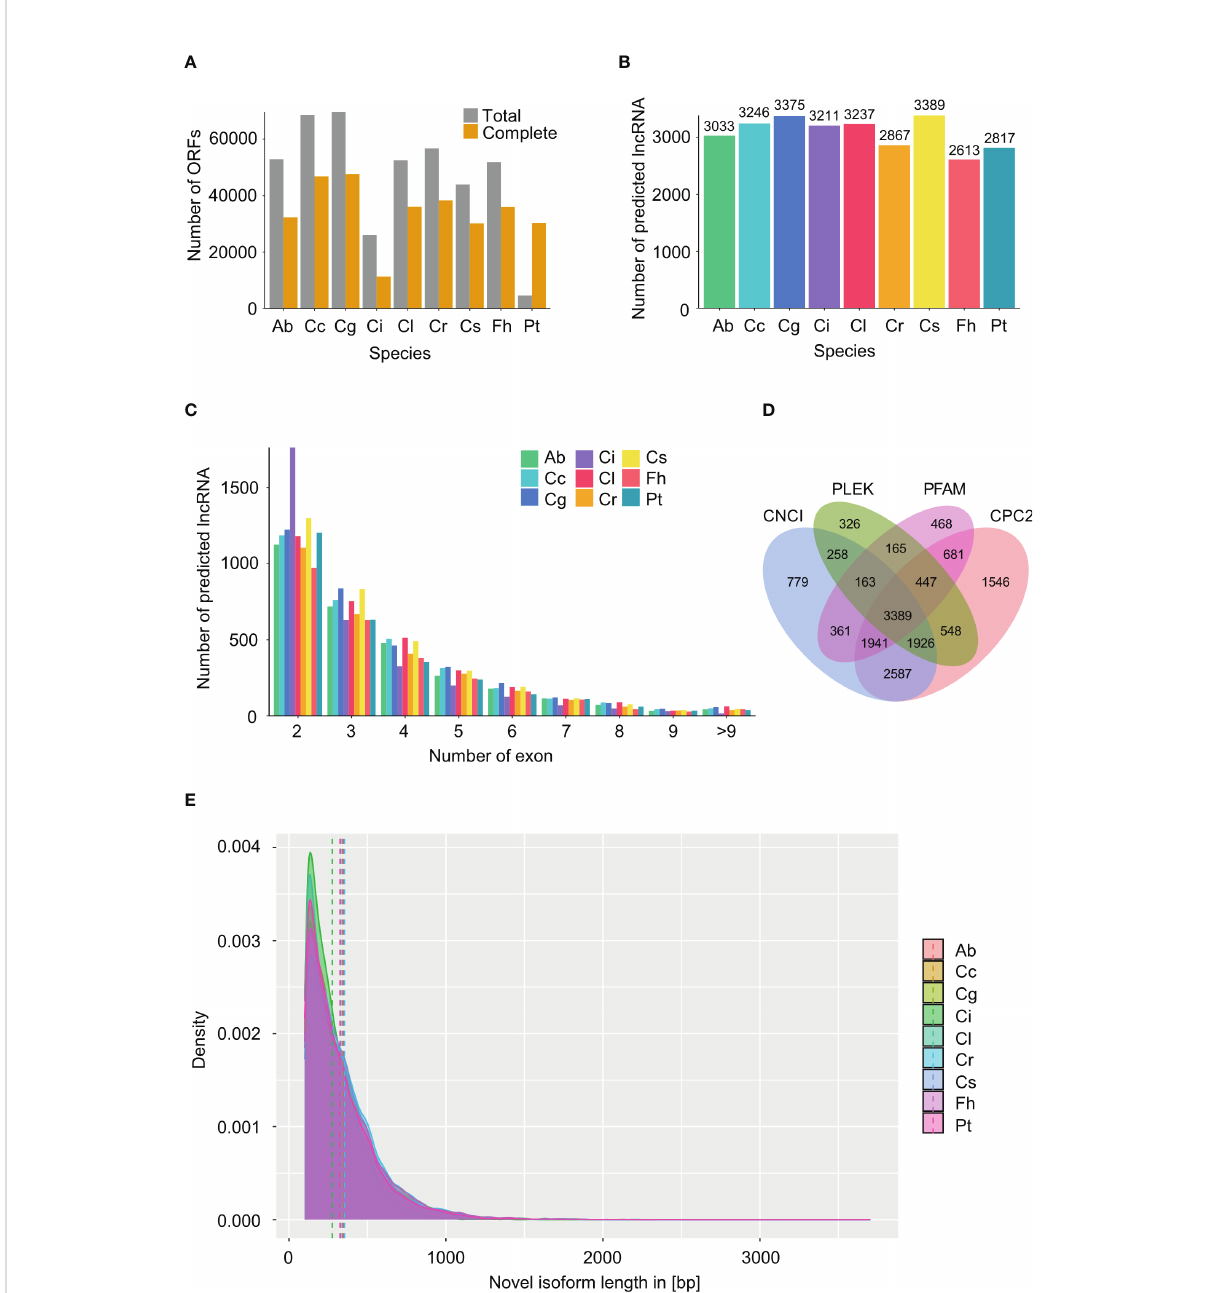
FIGURE 2 Information on identi fi ed ORFs and lncRNA. Atalantia buxifolia ; Cc, Citrus clementina ; Cg, Citrus grandis ; Ci, Citrus ichangensis ; Cl, Clausena lansium ; Cr, Citrus reticulata ; Cs, Citrus sinensis ; Fh, Fortunella hindsii ; Pt, Poncirus trifoliata . (A) Number of total and complete ORFs within novel isoforms in 9 species predicted using TransDecoder. (B) Number of lncRNA predicted by all four tools (CNCI, CPC2, PFAM and PLEK) in 9 species. (C) Number of exons within each predicted lncRNA in 9 species. Single exon lncRNAs were excluded. (D) Venn diagram of identi fi ed lncRNAs by using four tools (CNCI, CPC2, PFAM and PLEK) in Citrus sinensis. (E) Length distribution of novel isoforms with complete ORFs for 9 species. Dashed lines show the mean length of isoforms for each